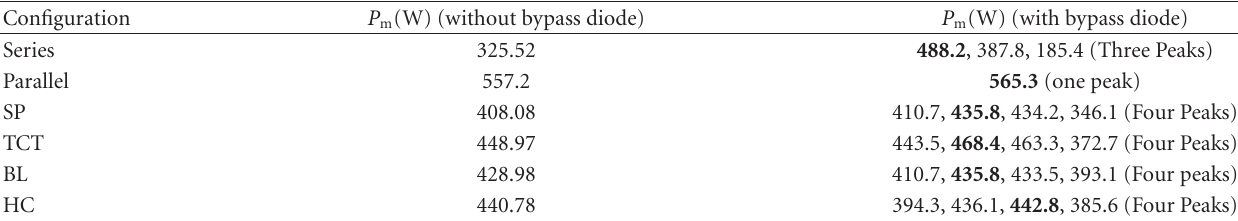
Table 3: Comparison of Configurations Power with and without Bypass Diode.